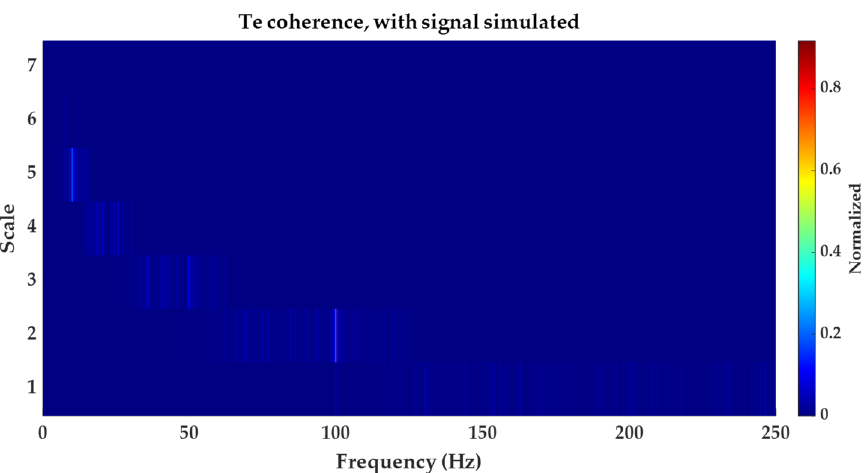
Figure 6. 𝒯 (cid:3032) coherence, with two synthetic signals: 𝑆 (cid:2869) = 𝑠𝑖𝑛(2𝜋10𝑡) + 𝑠𝑖𝑛(2𝜋100𝑡) and 𝑆 (cid:2869) = Figure 6. T e coherence, with two synthetic signals: S 1 = sin ( 2 π 10 t ) + sin ( 2 π 100 t ) and S 1 = 𝑠𝑖𝑛(2𝜋50𝑡) + 𝑠𝑖𝑛(2𝜋100𝑡) . sin ( 2 π 50 t ) + sin ( 2 π 100 t )